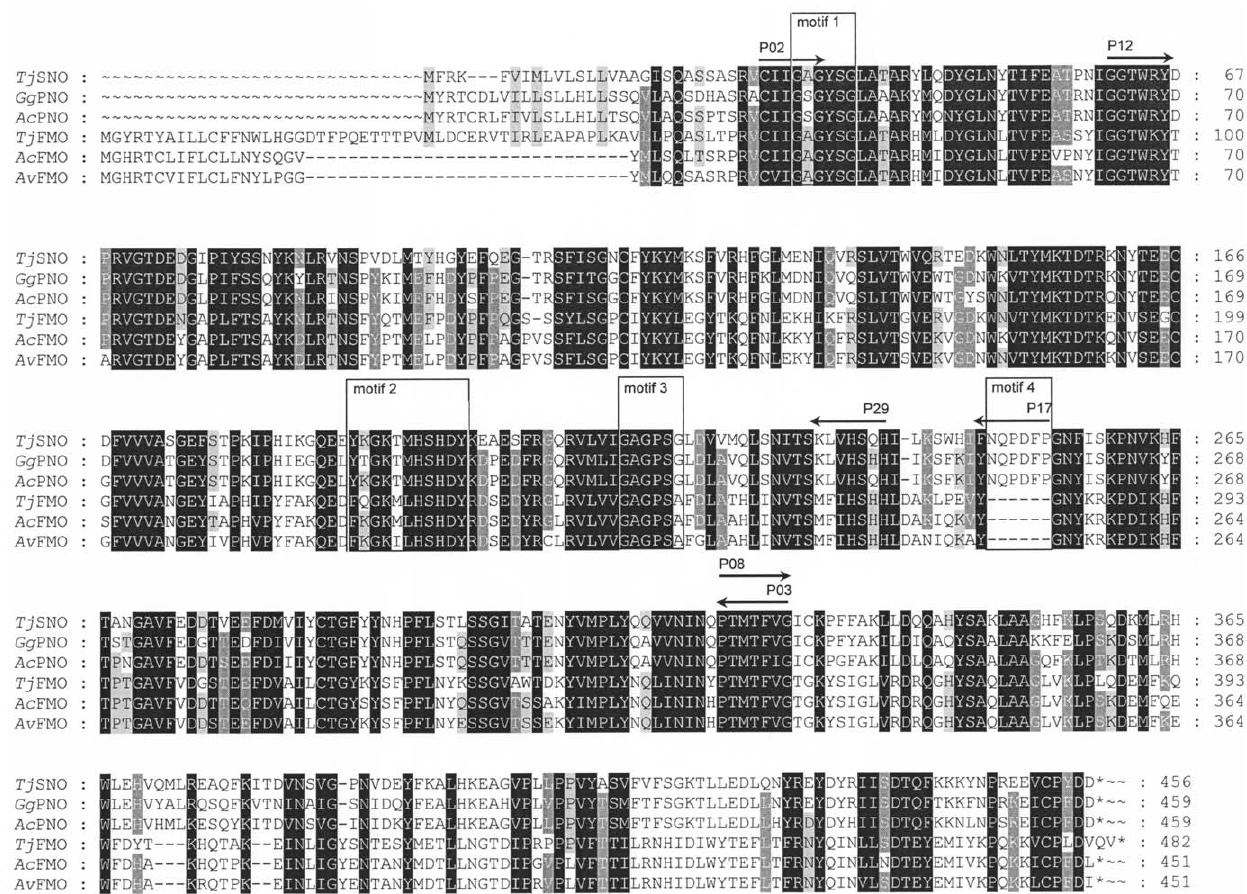
Figure 2. Alignment of the amino acid sequences of FMOs of various arctiid species. Motif 1, FAD-binding site; motif 2, FMO-identifying sequence; motif 3, NADPH-binding site; motif 4, insertion of six amino acids characteristic for sequences belonging to the putative PNO cluster;